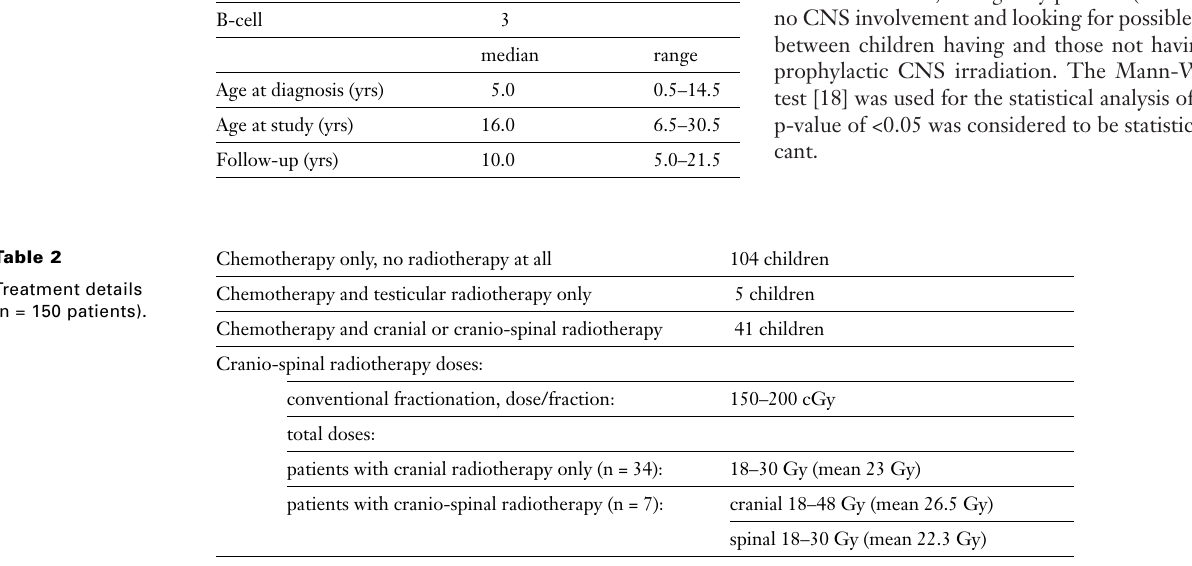
Patients characteris- tics (n = 150 patients; F = 70, M = 80).